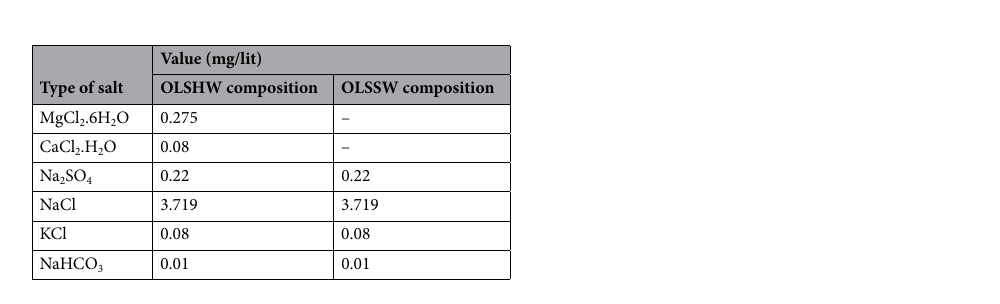
Table 10. OLSHW and OLSSW compositions with and without Mg 2+ and Ca 2 ions for preparation of nanofluids.